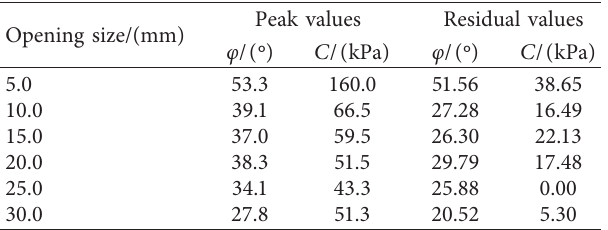
Figure 14: Variation of shear stress with horizontal displacement obtained by direct shear tests on G3 with a plate opening of (a) 5.0 mm, (b) 10.0mm, (c) 15.0mm, (d) 20.0mm, (e) 25.0mm, and (f) 30.0mm. (g) Failure envelopes for G3 under direct shear with different plate openings. Table 2: Peak and residual internal friction angle ( φ ) and cohesion ( C ) obtained by direct shear tests on G3 with six different plate opening